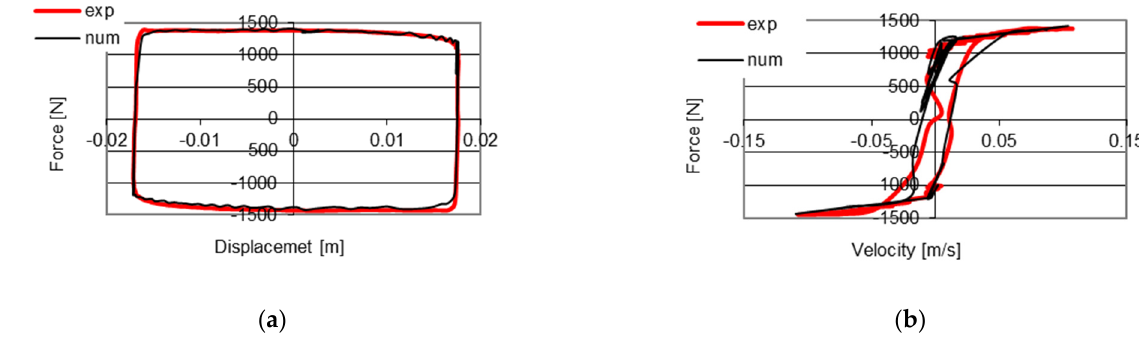
Figure 5. Comparison of results experimental and numerical research the MR damper with 2A current, ( a ) plane: force – displacement, ( b ) plane: force – velocity.